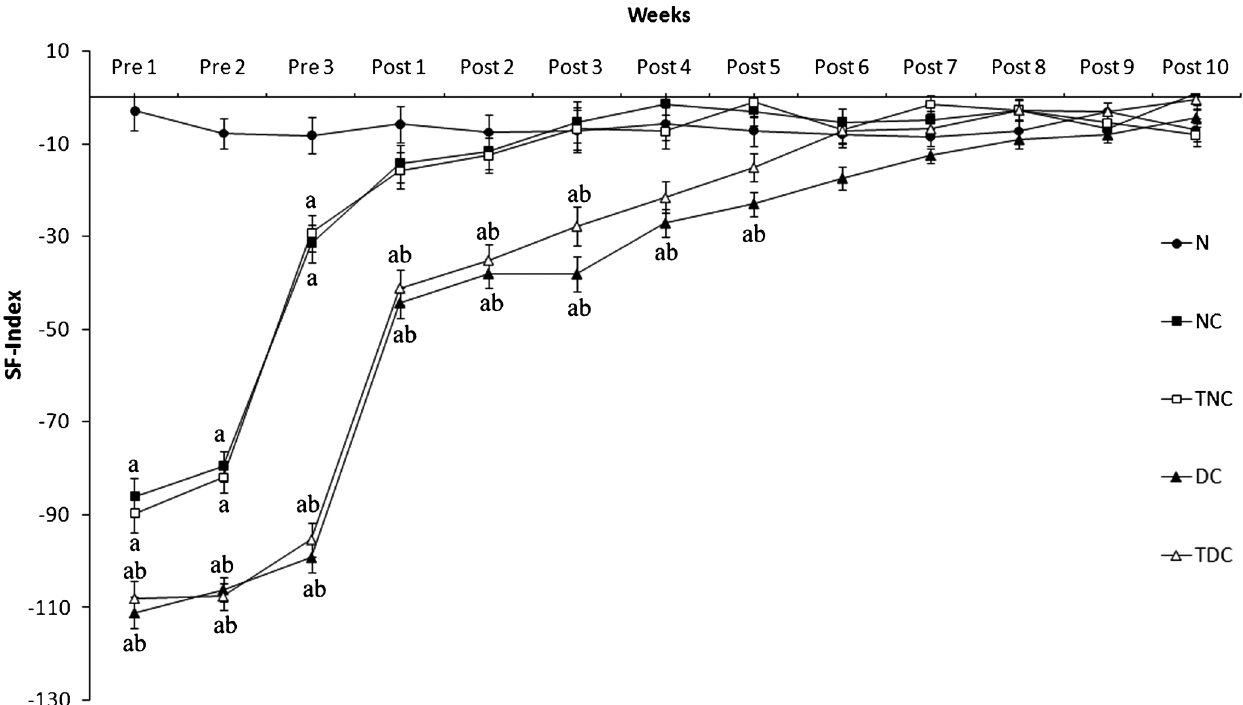
Figure 2 - Graphs showing functional recovery (sciatic functional index, SFI) before beginning the training program (pre 1-3 weeks) and after each week of the training period (post 1-10 weeks) in non-diabetic (N, n=6), non-diabetic with sciatic nerve crush (NC, n=6), trained non-diabetic with sciatic nerve crush (TNC, n=6), diabetic submitted to sciatic nerve crush (DC, n=9) and trained diabetic submitted to sciatic nerve crush (TDC, n=7) groups. a P , 0.05 vs. N group; b P , 0.05 vs. NC and TNC groups. Data are expressed as means ¡